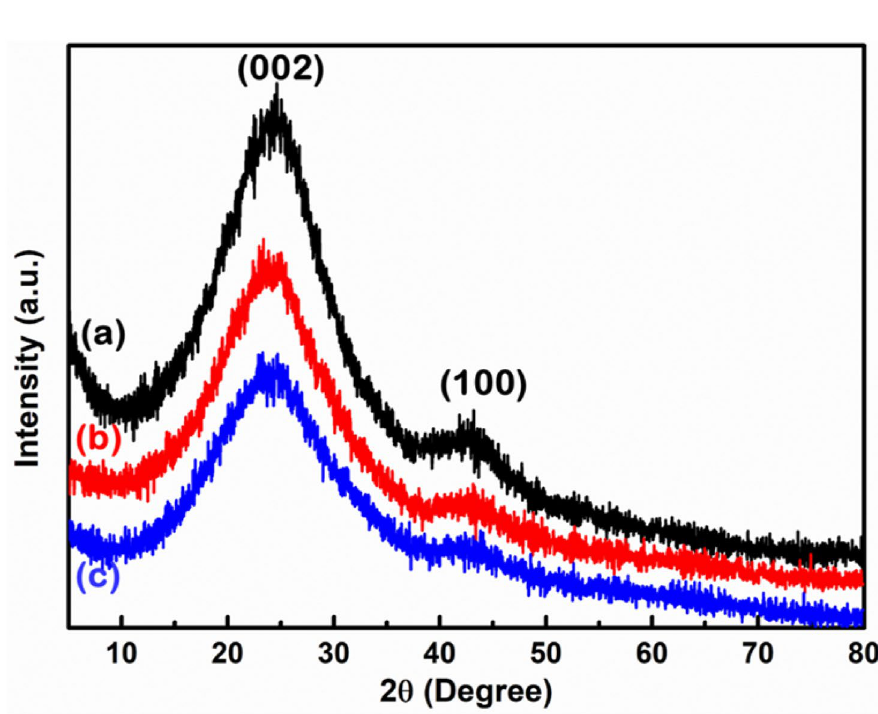
Figure 5. XRD spectra of CNS prepared at 650 °C from nettle ( a ) stems and ( b , c ) leaves using NaHCO 3 as activating agent. The ratio of nettle powder and NaHCO 3 is 1:1 ( a and b ) and 1:2 ( c